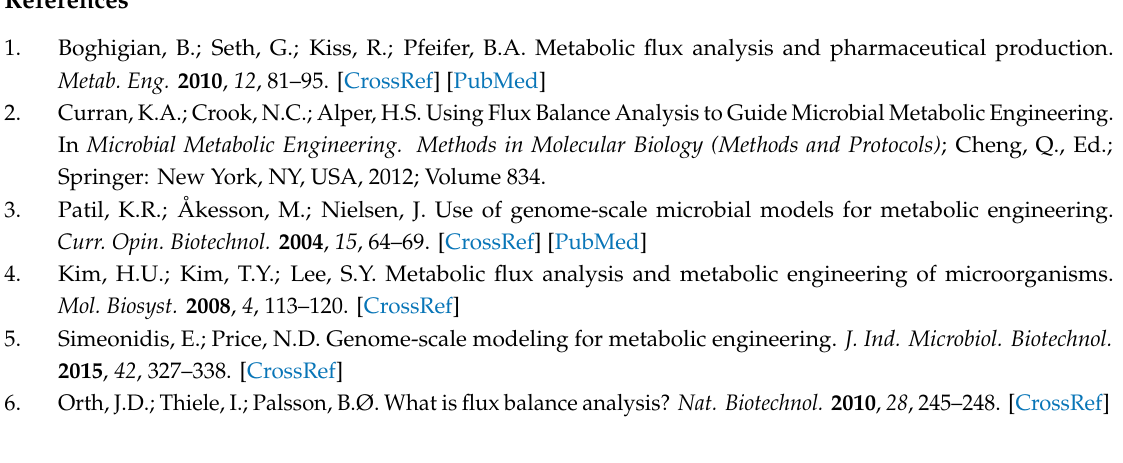
Table S1: Numerical data extracted from data of E. coli SA5 / pTH-aroG fbr -ppsA-tktA in Figure 3 of Chen et al., 2014